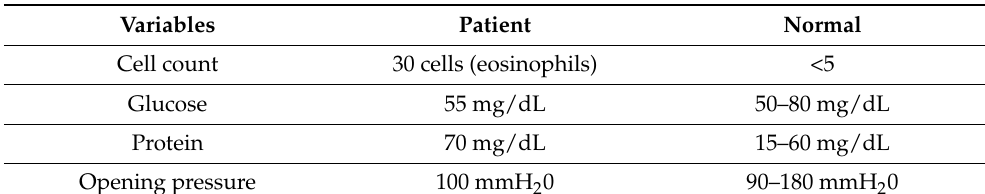
Table 1. Patient CSF analysis showing moderate pleocytosis with eosinophilia, and slight increase in protein.